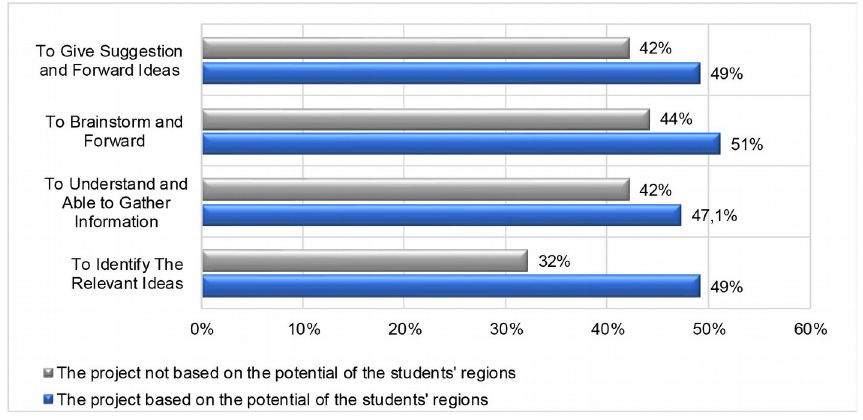
Figure 4. The comparison on students’ perception of Project